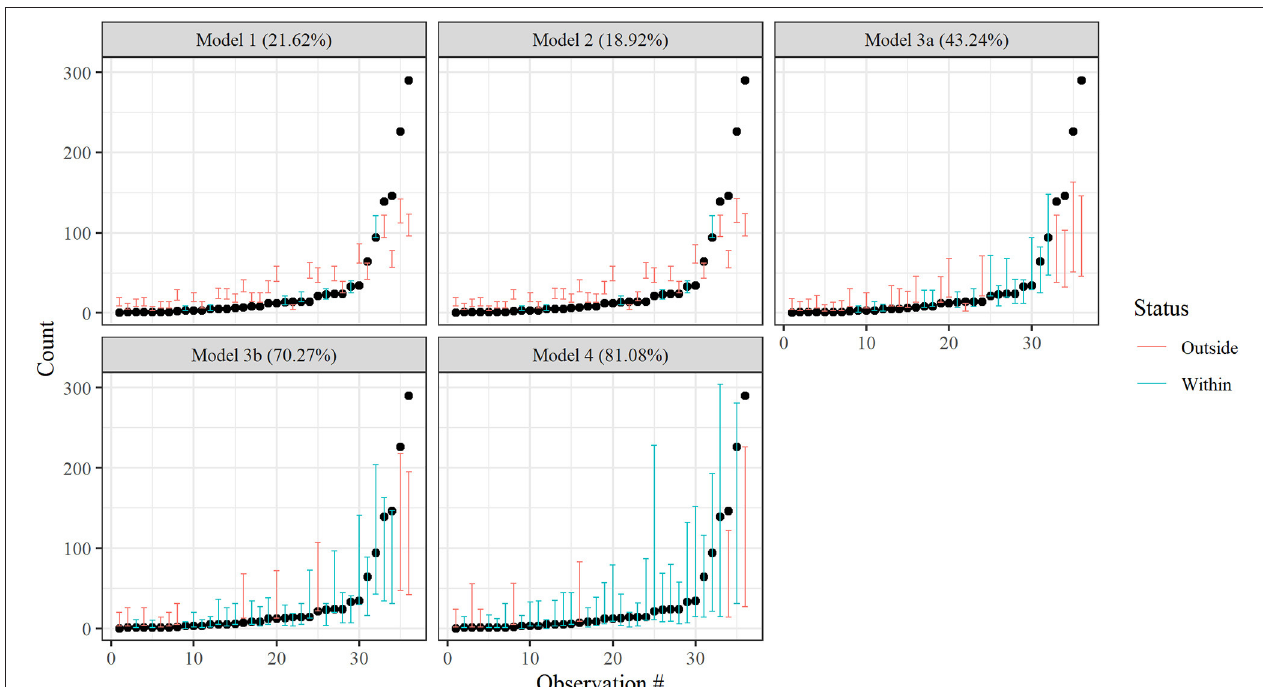
FIGURE 2 | Leave-future-out cross validation results for Models 1–4. Bars denote nominal 80% Bayesian prediction intervals derived from posterior predictive distributions, while dots depict observed crab counts for 2017. Red bars indicate an observed value is outside the prediction interval, while blue bars indicate an observed value is within the prediction interval. Actual coverage percentages of prediction intervals (= % of blue) appear in the panel